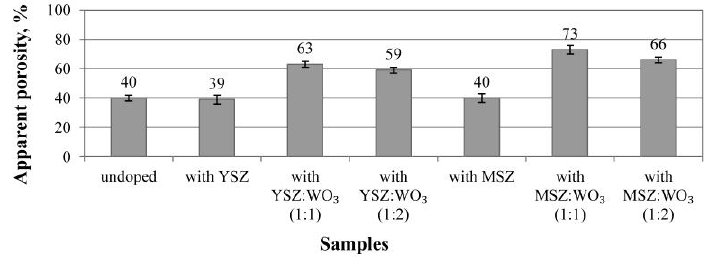
Figure 7. Apparent porosity of the investigated